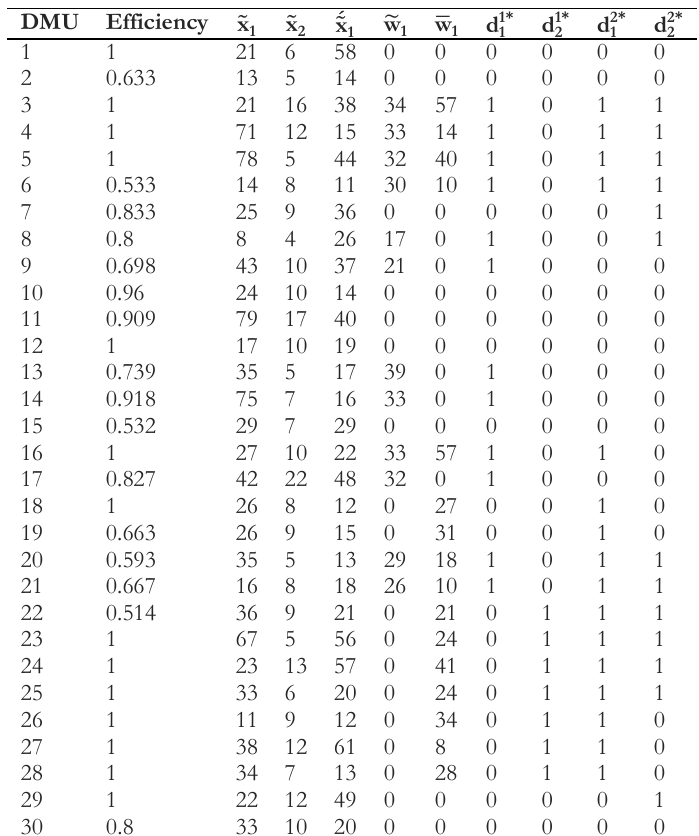
Table 4. The results obtained from the IFNDEA Model